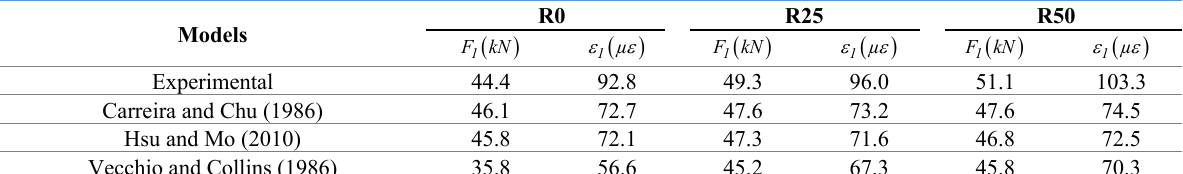
Table 6. Tension stiffening test properties at the cracking start.